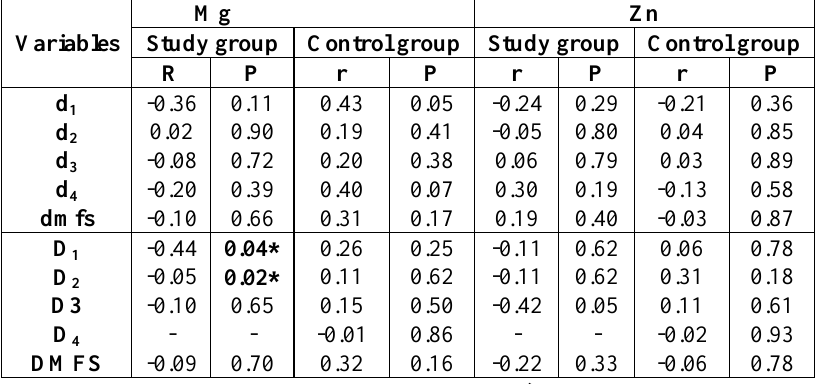
Table 6: Correlation coefficient between salivary magnesium and zinc and caries experience among females of study and control groups (ds grades, dmfs, DS grades and DMFS) Mg Zn Study group Control group Study group Control group Variables R P